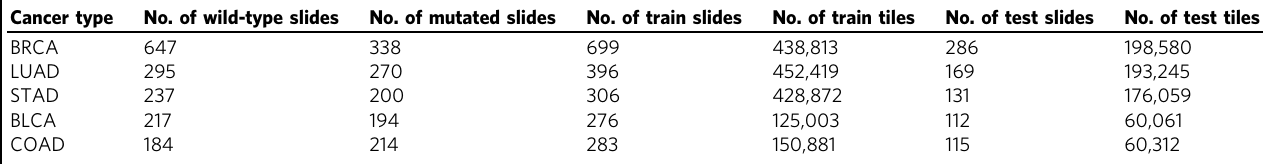
Table 1 Numbers of wild-type and mutated slides in each TP53 cancer